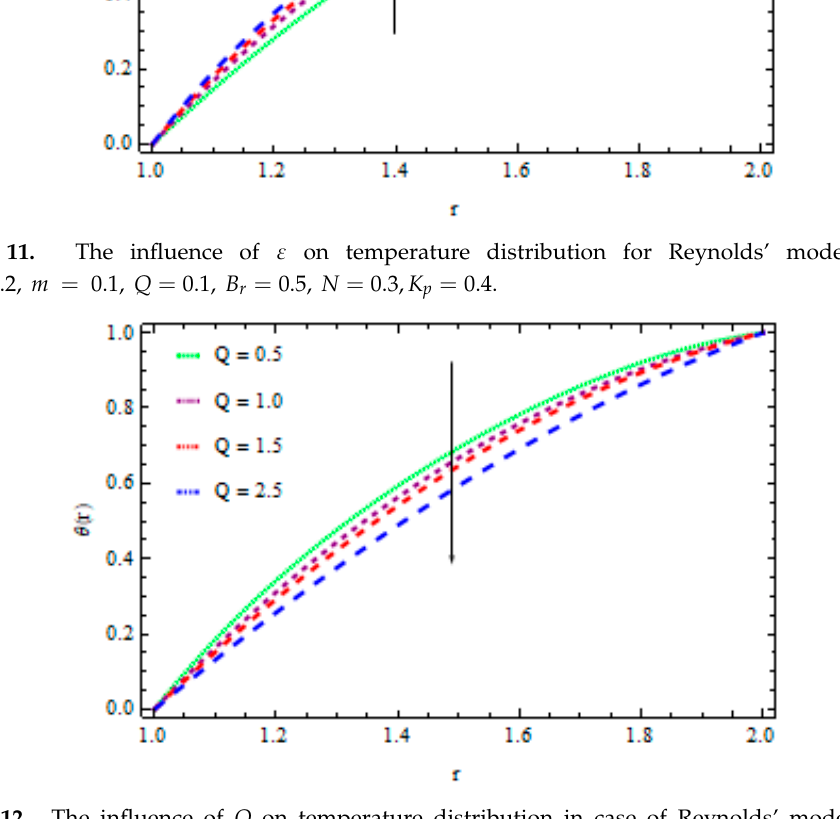
Figure 13. The influence of Ω on temperature distribution for Vogel’s model when ' 1.2,